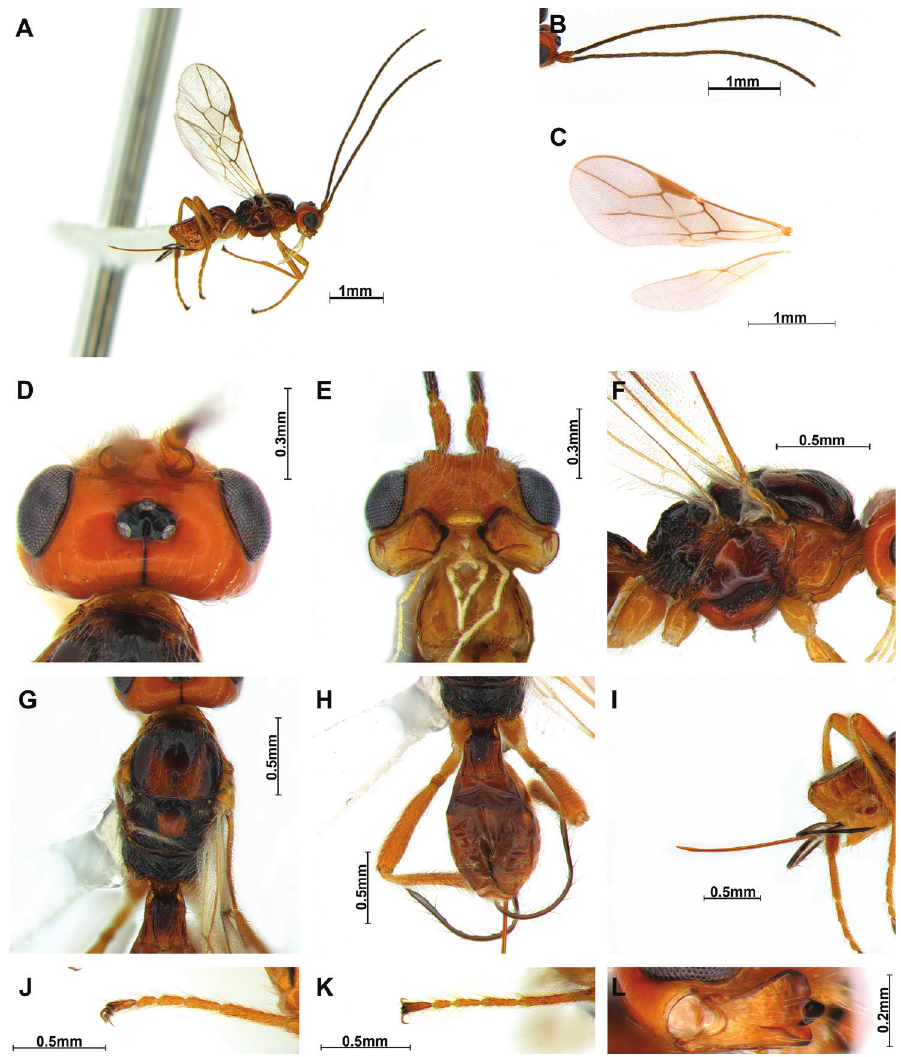
Figure 6. Phaenocarpa ruficeps (Nees, 1812), ♀ A body B antennae C wings D head, dorsal E head, ante- rior F mesosoma, lateral G mesosoma, dorsal H propodeum and metasoma, dorsal I metasoma,ovipositor and its sheaths, lateral J tarsus, lateral K tarsus, dorsal L mandible,